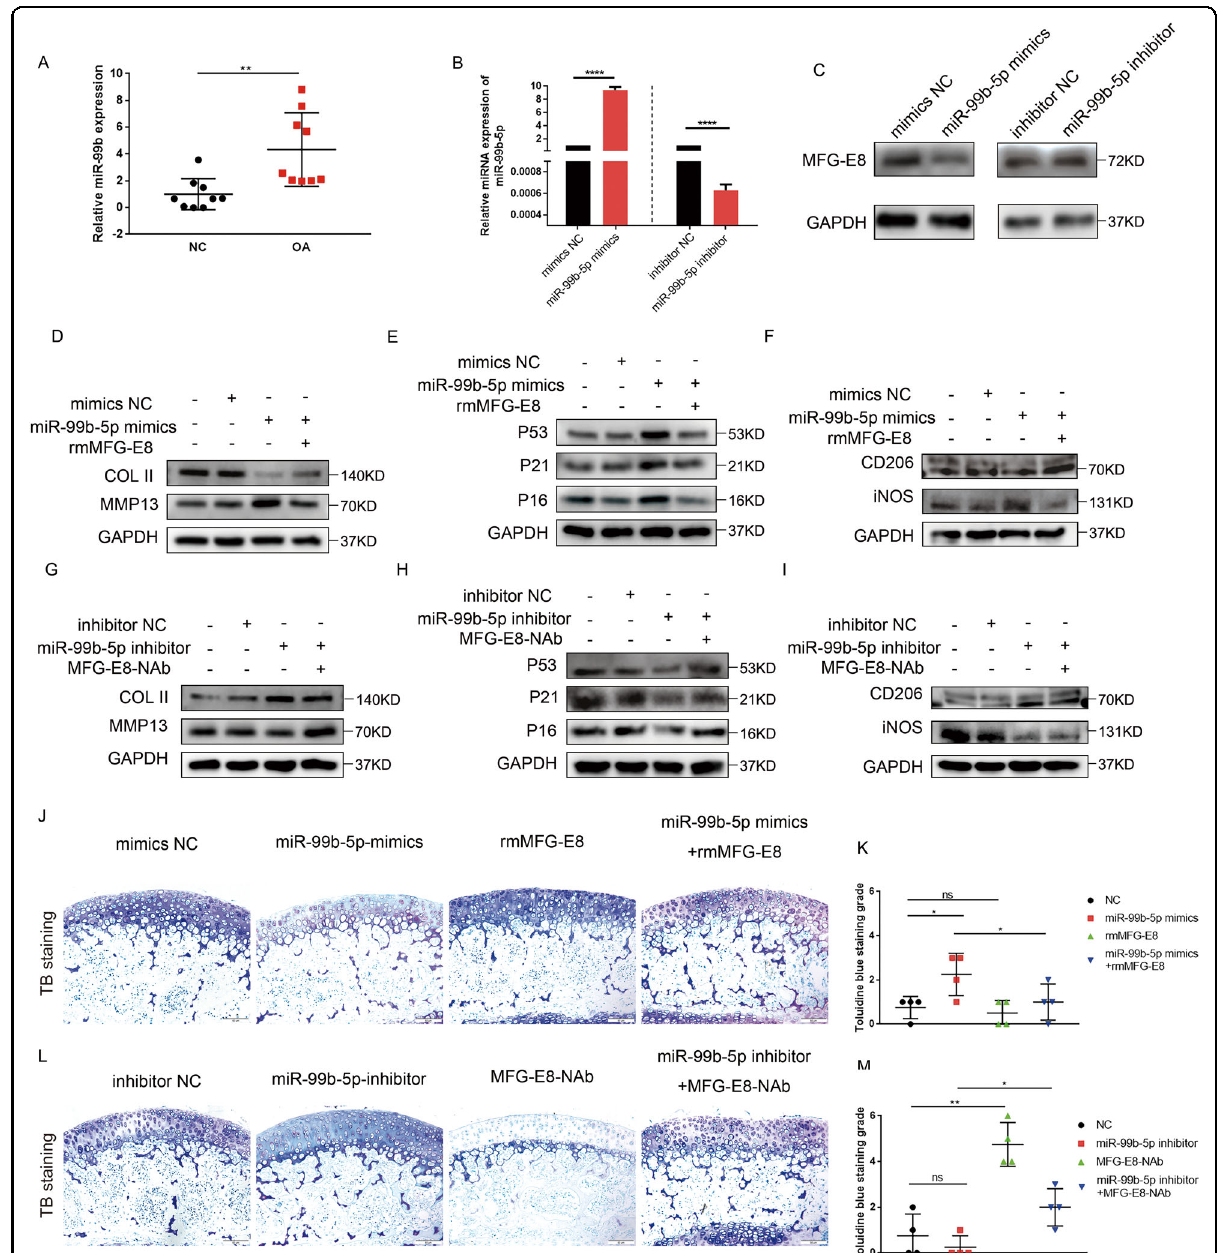
Fig. 6 MiR-99b-5p regulates MFG-E8 expression in OA. A Relative expression of miR-99b-5p in articular cartilage of human knees from the lateral (NC) or medial (OA) tibial plateaus, n = 9 per group; B Relative expression of miR-99b-5p in primary murine chondrocytes transfected with miR-99b- 5p mimics and inhibitor, n = 3; C Immunoblotting of MFG-E8 in primary murine chondrocytes treated with miR-99b-5p mimics and inhibitor; D Immunoblotting of Collagen II and MMP13 in miR-99b-5p mimics- or rmMFG-E8- treated primary murine chondrocytes; E Immunoblotting of senescence markers (P16, P21, P53) in miR-99b-5p mimics- or rmMFG-E8- treated primary murine chondrocytes; F Immunoblotting of iNOS and CD206 of RAW264.7 cells with miR-99b-5p mimics transfection or rmMFG-E8 administration; G Immunoblotting of Collagen II and MMP13 in miR- 99b-5p inhibitor- or MFG-E8-NAb- treated primary murine chondrocytes; H Immunoblotting of senescence markers (P16, P21, P53) in miR-99b-5p inhibitor- or MFG-E8-NAb- treated primary murine chondrocytes; I Immunoblotting of iNOS and CD206 of RAW264.7 cells with miR-99b-5p inhibitor transfection or MFG-E8-NAb treatment; J , K Toluidine blue (TB) staining and grade of mouse tibial plateaus cartilage explants treated with miR-99b-5p mimics and/or rmMFG-E8; n = 4 per group; Scale bar: 50 µm; L , M TB staining and grade of mouse tibial plateaus cartilage explants treated with miR- 99b-5p inhibitor and/or MFG-E8-NAb; n = 4 per group; Scale bar: 50 µm; * P < 0.05, ** P < 0.01, **** P < 0.0001, ns not signi fi